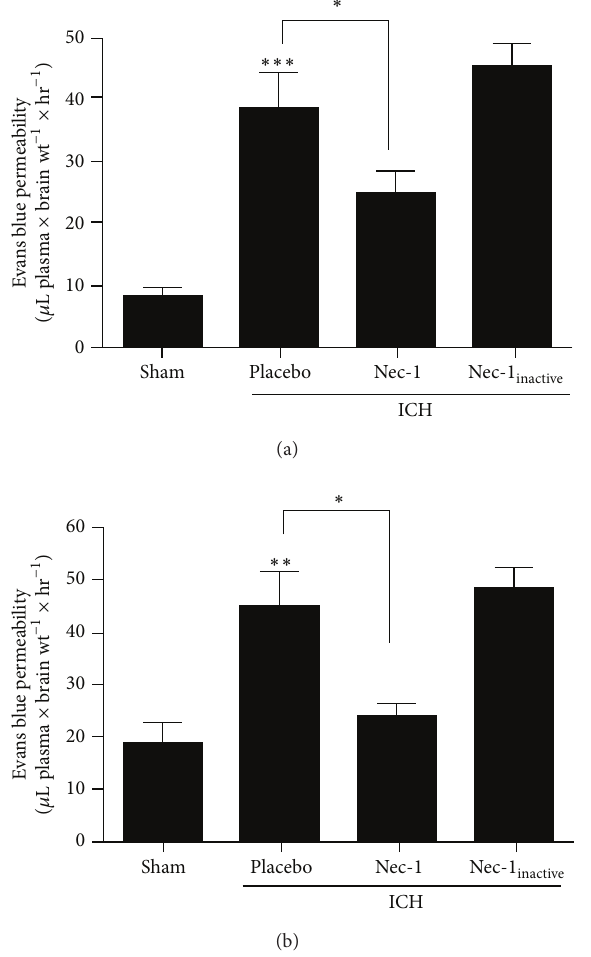
Figure 6: Nec-1 reduced edema development after ICH. Mice Figure 5: Nec-1 maintains blood-brain barrier integrity after at the time of collagenase- were administered Nec-1 or Nec- 1 inactive at the time ICH. Mice were administered Nec-1 or Nec- 1 inactive induced ICH. Brain water content, a measure of cerebral edema, of collagenase-induced ICH. Evans blue extravasation, a sensitive was assessed in the ipsilateral hemisphere at (a) 24 h or (b) 72 h measure of BBB disruption, was assessed at (a) 3h or (b) 12h after following ICH. Comparisons within each hemisphere between ICH. Data are expressed as mean ± SEM and were analyzed by one- different treatment groups were done using a one-way ANOVA way ANOVA followed by Student- Newman-Keuls post hoc test followed by Student-Newman-Keuls post hoc test ( ∗ 𝑃 < 0.05 , ( ∗∗ 𝑃 < 0.01 , ∗∗∗ 𝑃 < 0.001 , 𝑛 = 7-8 per group). ∗∗∗ 𝑃 < 0.001 ). Data are expressed as mean ± SEM from 10 mice per